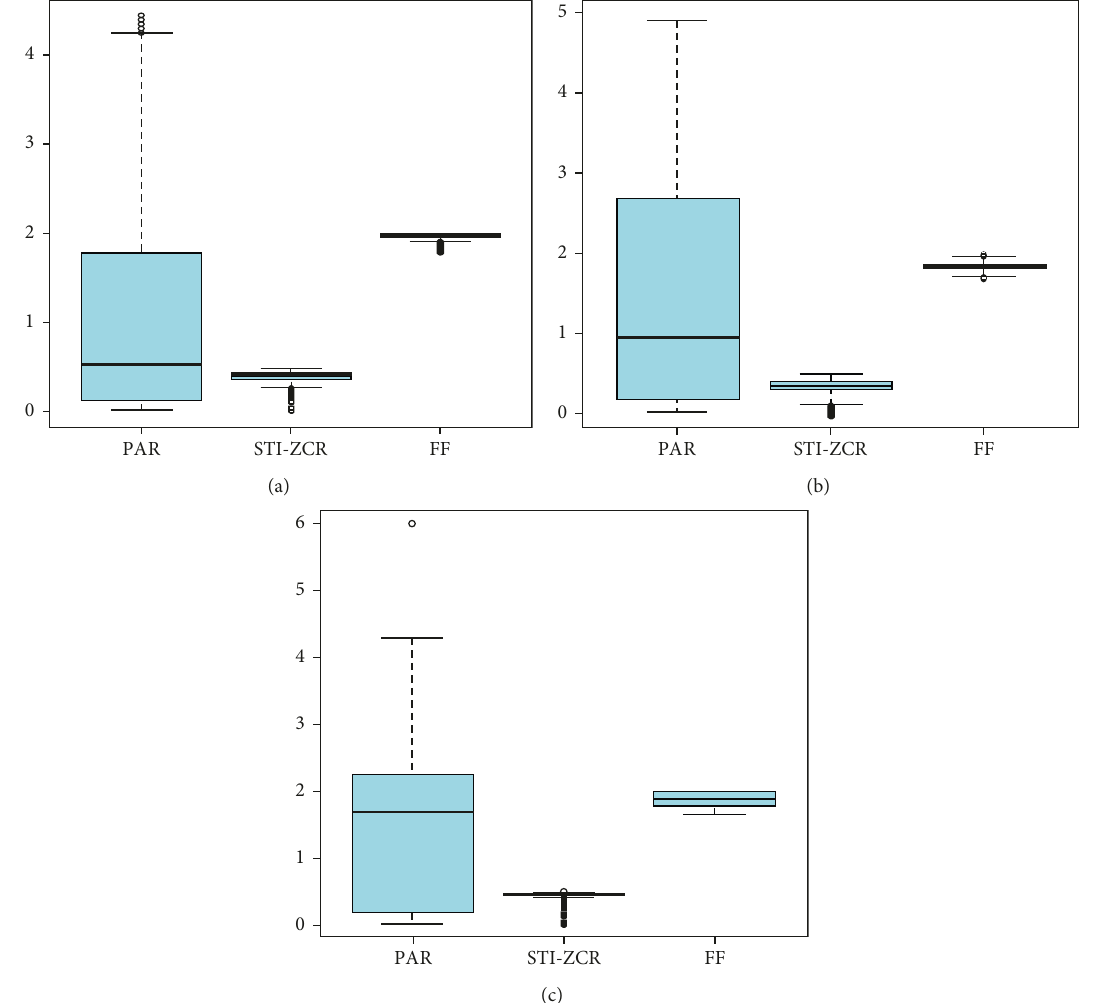
Figure 6: Feature distribution of the three microstates. (a) Hybrid features of gas leakage. (b) Hybrid features of liquid leakage. (c) Hybrid features of mixed